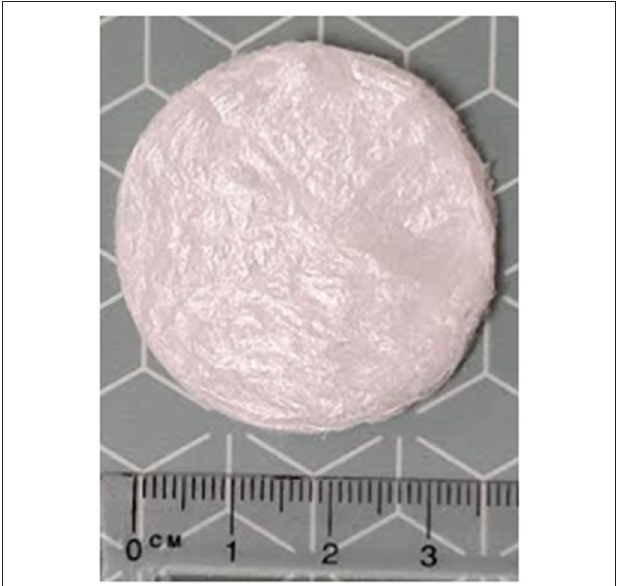
FIGURE 1 | Beta-chitin patch following